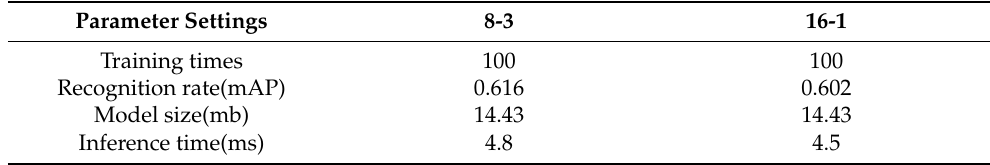
Table 2. DenseBlock module experimental parameter table.